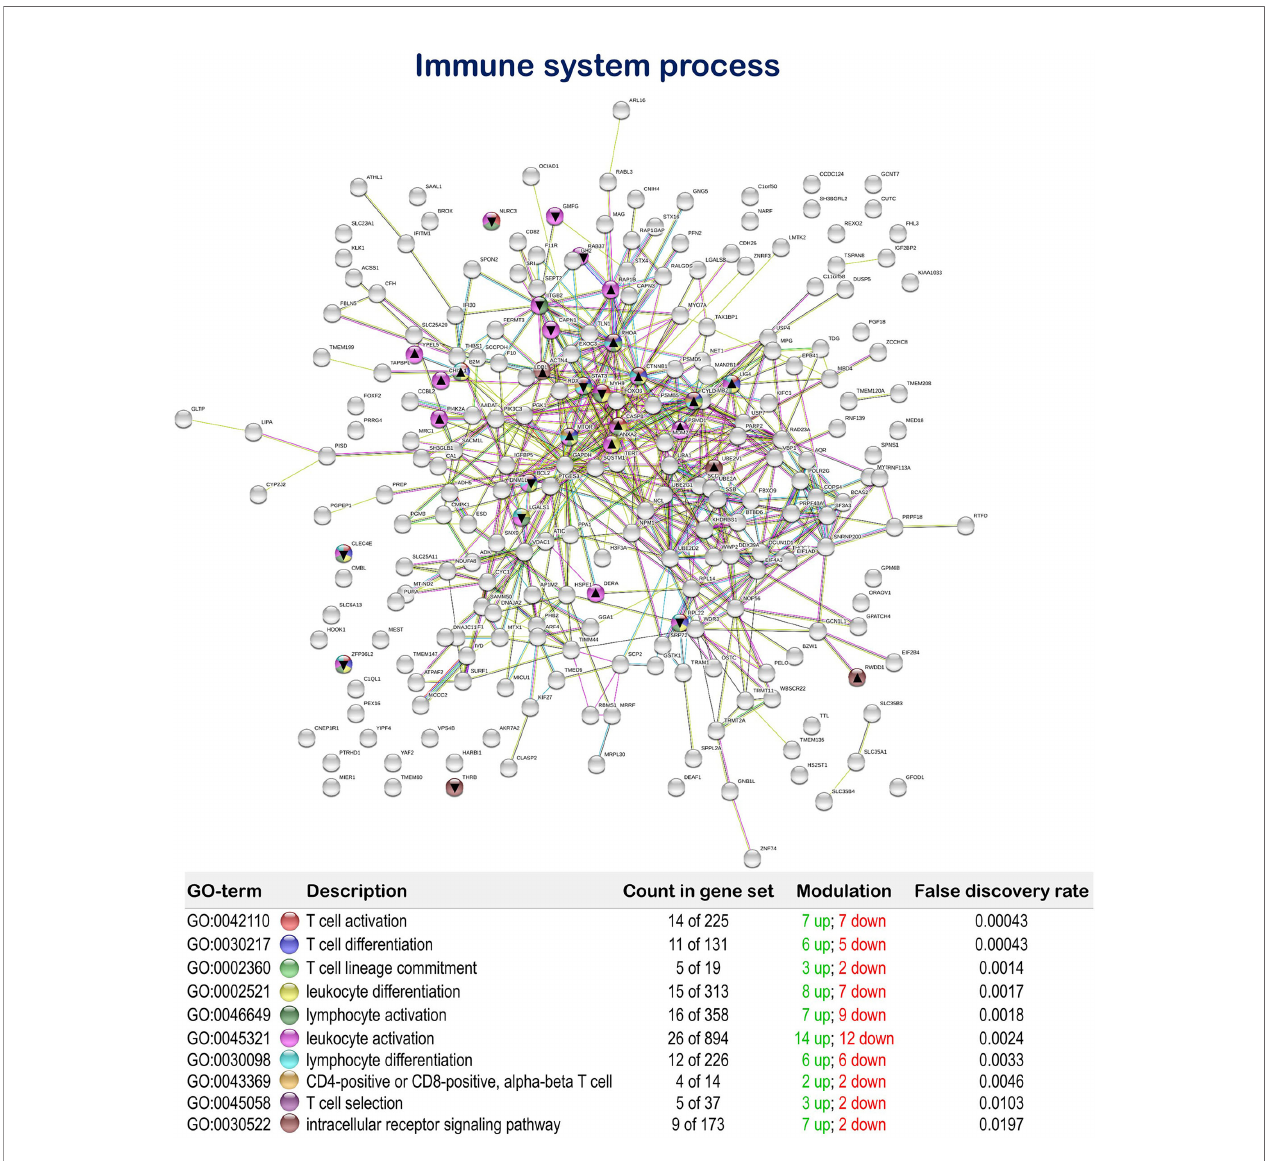
FIGURE 5 | Immune system process related Protein-Protein Interactions Network (PPI) network of the differentially expressed genes (DEGs) in the mid-anterior intestine of juvenile gilthead seabream ( Sparus aurata ) fed the mixture of MPLE obtained from sage ( S. of fi cinalis ) and lemon verbena ( L. citriodora ) (see also Supplementary Table 3 ). Nodes colors indicate the biological processes for each DEG represented. Gene Ontology (GO) de fi nitions, count of DEGs within each biological processes and respective false discovery rate are described in the graphical fi gure legend. ▲ nodes represent up-regulated genes and ▼ nodes represent down-regulated genes. Graphic keys and network stats are indicated in the graphical fi gure legend. Network Stats: number of nodes: 243; number of edges: 550; average node degree: 4.53; avg. local clustering coef fi cient: 0.416; expected number of edges: 423; PPI enrichment p-value: 1.98e-09. The MPLE included in the basal diet was obtained from sage ( Salvia of fi cinalis ) and lemon verbena ( Lippia citriodora